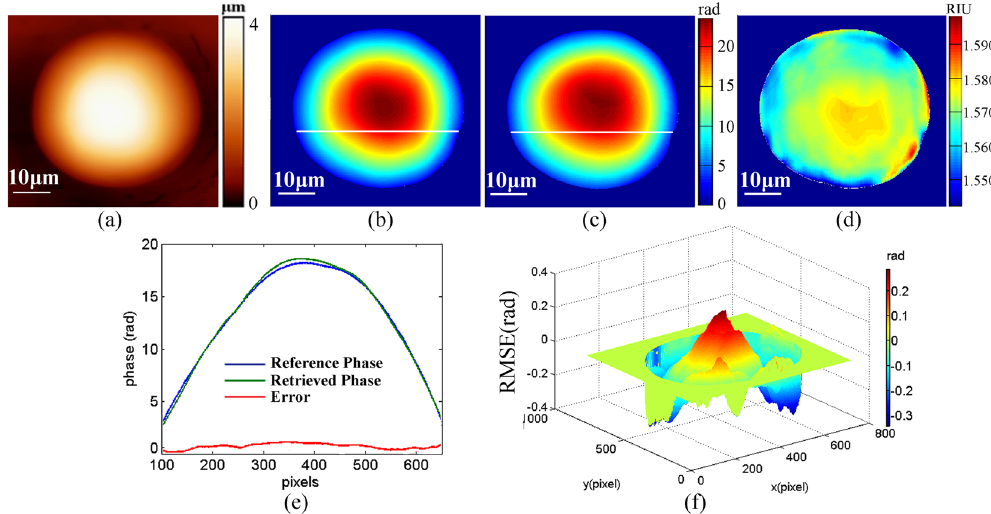
Figure 2. Experimental results of a homogeneous hemispherical particle on the light guide plate achieved with the proposed PSI/AFM based refractive index measurement system, in which the height distribution ( a ) and the retrieved phase ( b ) were respectively achieved by AFM imaging and PSI technique; the reference phase ( c ) achieved from Eq. (2) with the nominal refractive index and height distribution; the refractive index (RI) distribution ( d ) directly calculated from Eq. (2); ( e ) the phase distribution curves of the white line marked in ( b) and ( c ), as well as and the corresponding error between the reference phase and the retrieved phase; ( f ) the error of phase retrieval achieved with PSI